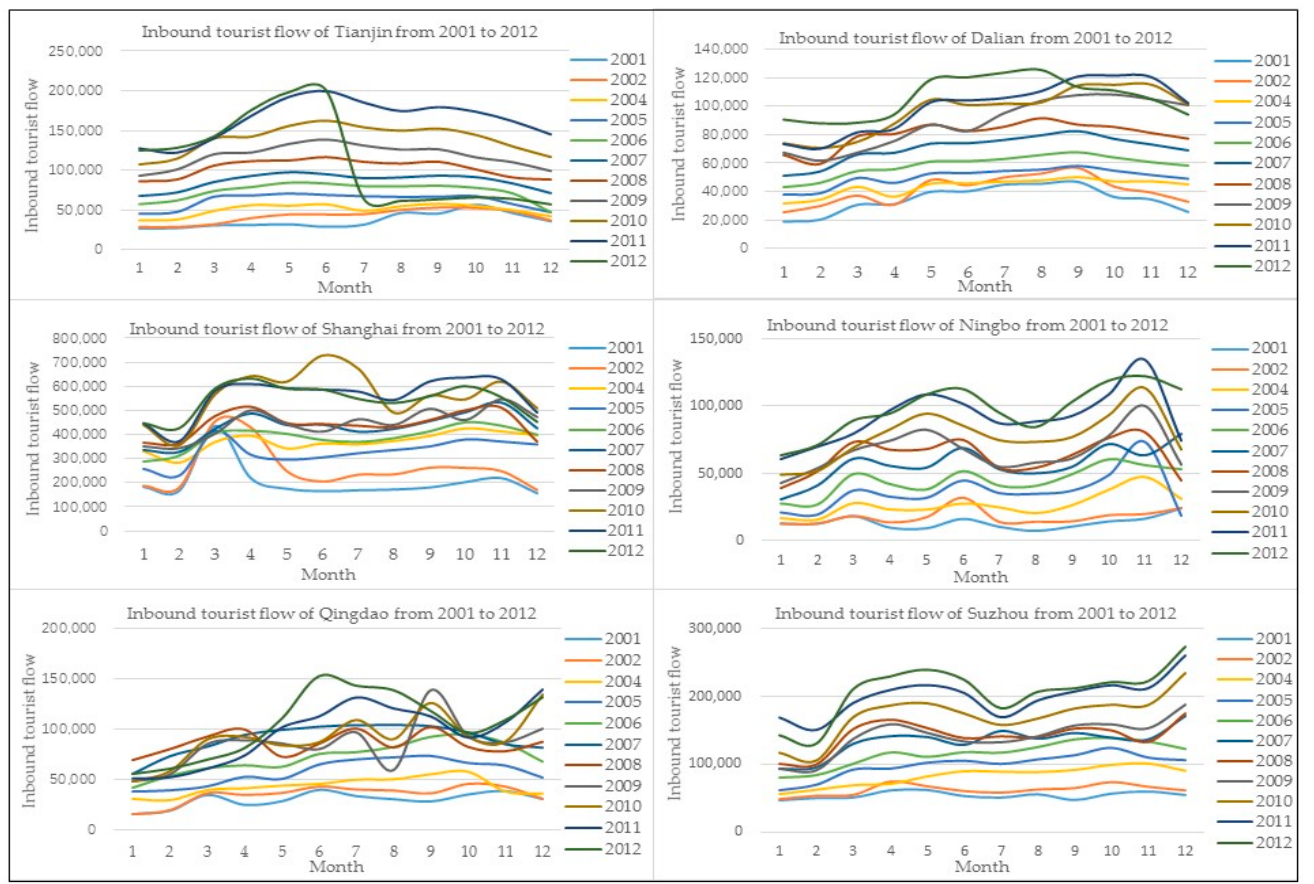
Figure 1. Non-peak. Source: authors’ research and edited, and same as Figures 2–4.